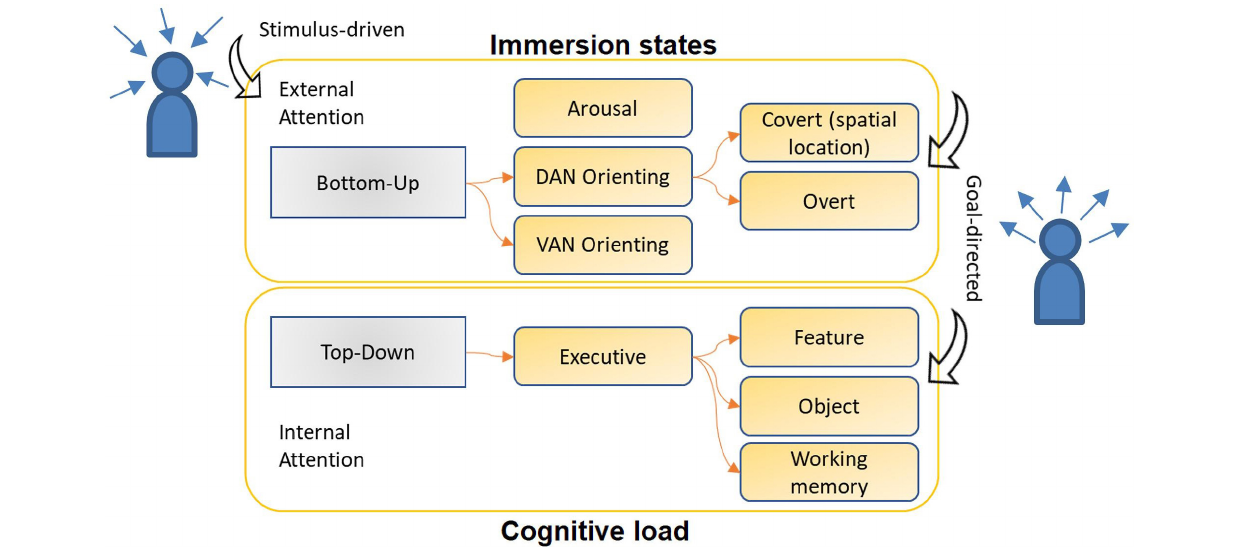
FIGURE 1 | Attention taxonomy merging traditional definitions. Attention allocation can be detected from different approaches, the internal or external triggers may characterize attention in immersive or cognitive load state. Upper box: the arrows point to the subject’s head – the elements that make up the stimulus path come from the external environment into the individual – so the attention allocation is guided by the stimulus – ‘stimulus- driven’ – prevailing in higher immersion states (due to screen or virtual environment stimuli). ‘Arousal’ – first box and first reflex of the stimulus perception. Lower box: elements that involve internal attention allocation, ‘executive’ relates the first cognitive reflex of the content selection for oriented attention. ‘Goal-directed’ – attention oriented from an internal stimulus – prevailing in higher cognitive load states –, but, the goal-directed mechanism also occurs when external stimulus-oriented attention reaches its target, so the goal-directed arrows cross both stimuli directions showing the two boxes interaction. Schematic overview inspired on (Chun et al., 2011) work.